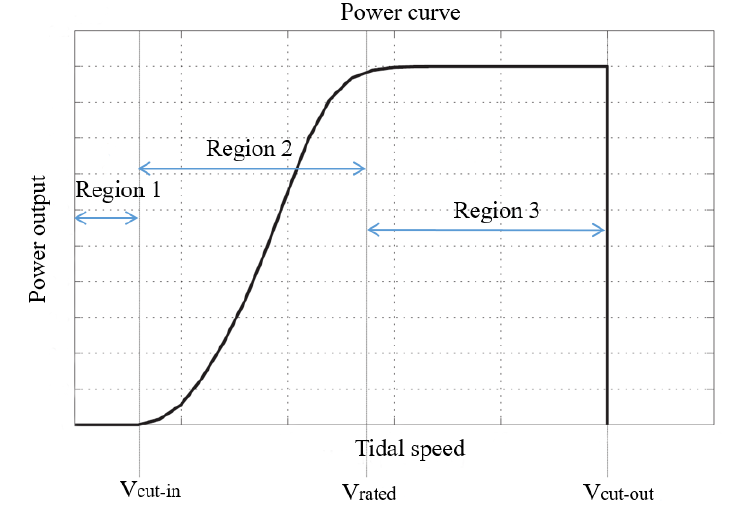
Figure 2. Power curve of a typical